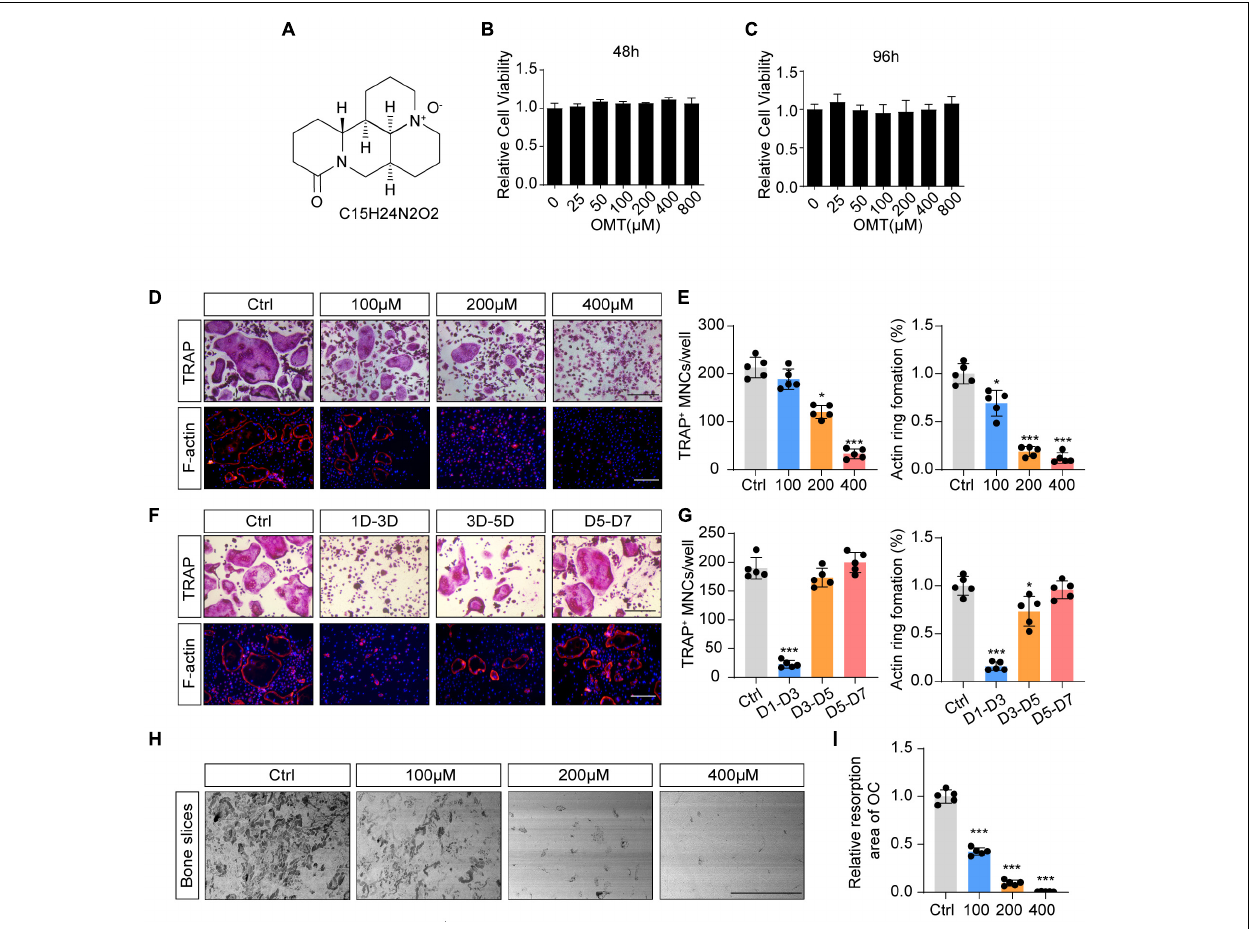
FIGURE 1 | OMT inhibits RANKL-induced osteoclast formation and activity in vitro . (A) The chemical structure and formula of OMT. (B,C) Cell viability of OMT-treated BMMs at 48 and 96 h. (D) BMMs were stimulated by 30 ng/mL M-CSF and 50 ng/mL RANKL, and treated with indicated concentrations of OMT for 5 days. Representative images of TRAP staining and F-actin staining were shown. Scale bar = 200 µ m. (E) Quantification of TRAP-positive multinuclear cells and F-actin ring formation rate. (F) BMMs were stimulated with 30 ng/mL M-CSF and 50 ng/mL RANKL for 7 days, and treated with 200 µ M OMT for the indicated days. TRAP staining and F-actin ring staining were performed. Scale bar = 200 µ m. (G) Quantification of TRAP-positive multinuclear cells and F-actin ring formation rate. (H) Representative images of bone resorption pits. Scale bar = 500 µ m. (I) Quantification of resorption pit area in each group. Data were presented as means ± SD of 5 independent experiments. * p < 0.05, *** p <